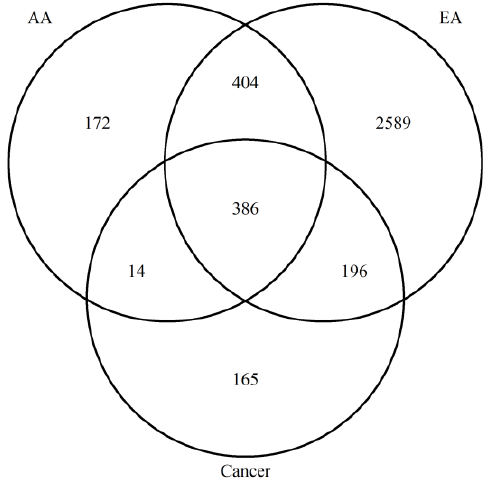
Figure 3. Venn diagram to show the overlap between age- and RC-DMRs identified.